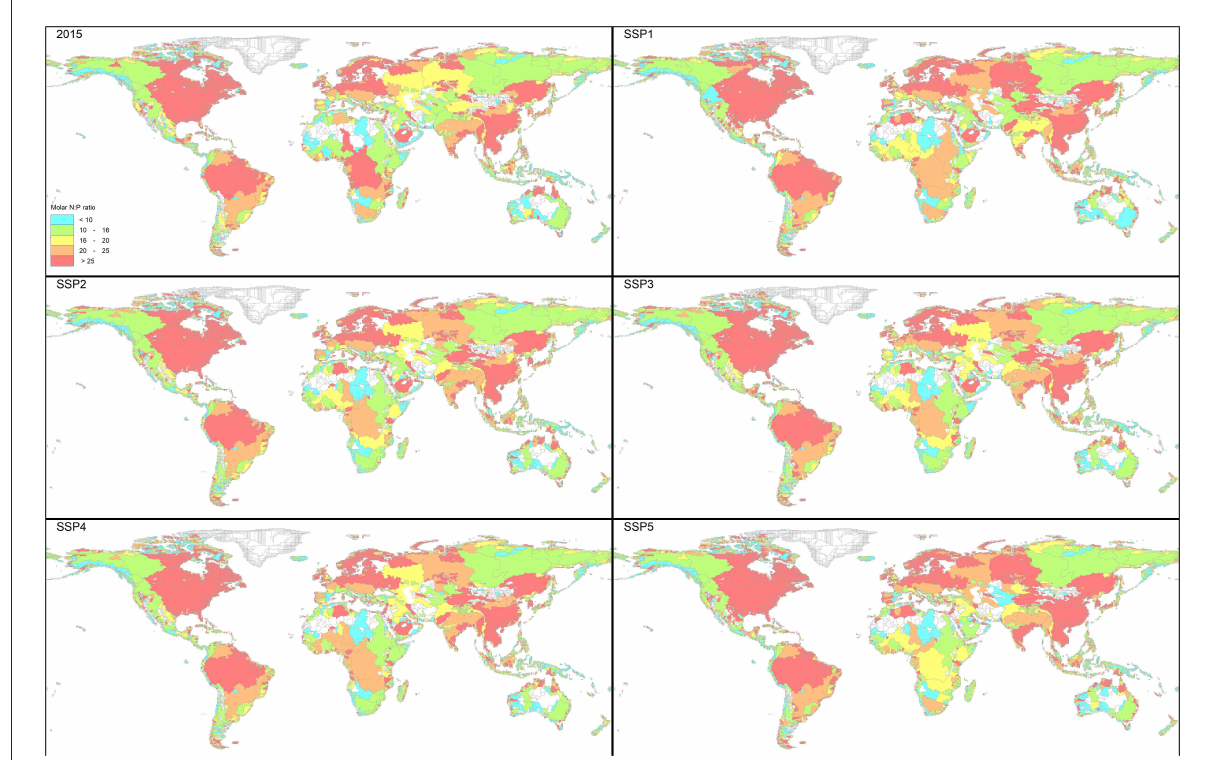
FIGURE5 Molar ratio of total N: total P (here denoted as N:P) in the river export to global coastal waters for the year 2015 and 2050 for the five SSPs.